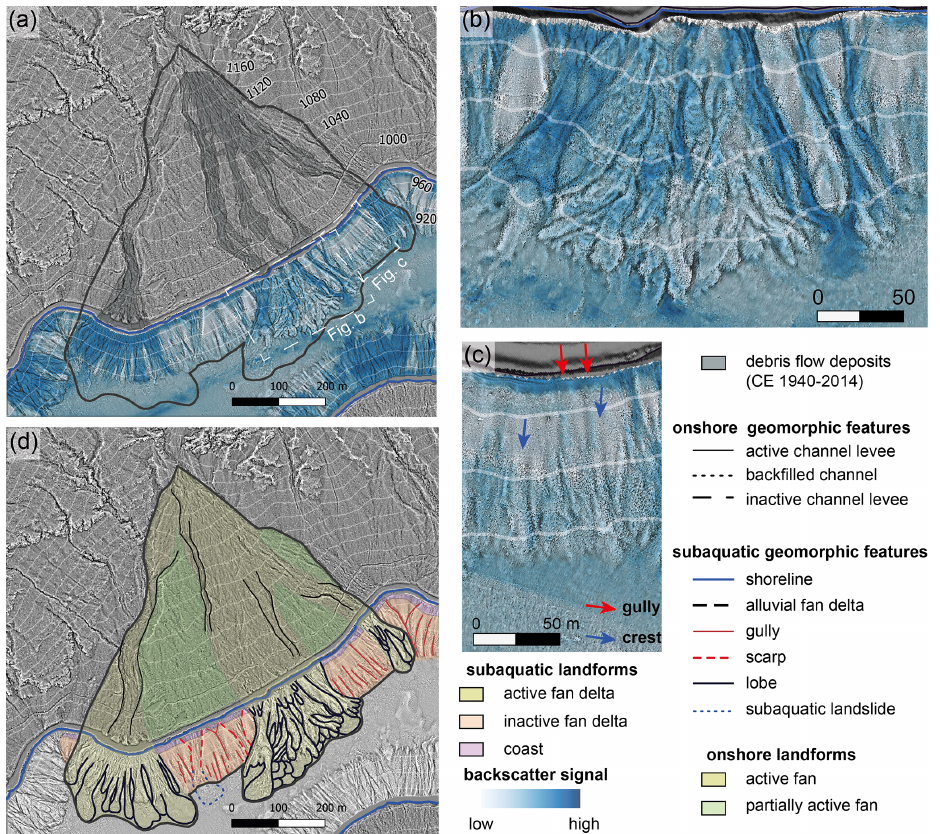
Figure 2. Combined onshore and offshore geomorphic characterization of the calibrate fan delta with known recent debris flow activity. (a) Topographic openness difference map overlain by the multibeam backscatter data (blue colour bar) and the documented debris flow deposits between 1947 and 2014 (Dietrich and Krautblatter, 2017). (b) Magnified view of an active part of the fan delta showing stacked and braided debris flow lobes with intermediate to high backscatter signals. (c) Magnified view of an inactive part of the fan delta showing the rel- atively regular pattern of crests and gullies. (d) Geomorphic-interpreted fan delta showing characteristic terrestrial and subaquatic landforms for active and inactive fans and fan deltas. Onshore DEM is derived from Land Tirol (https://data.tirol.gv.at, last access: 31 January